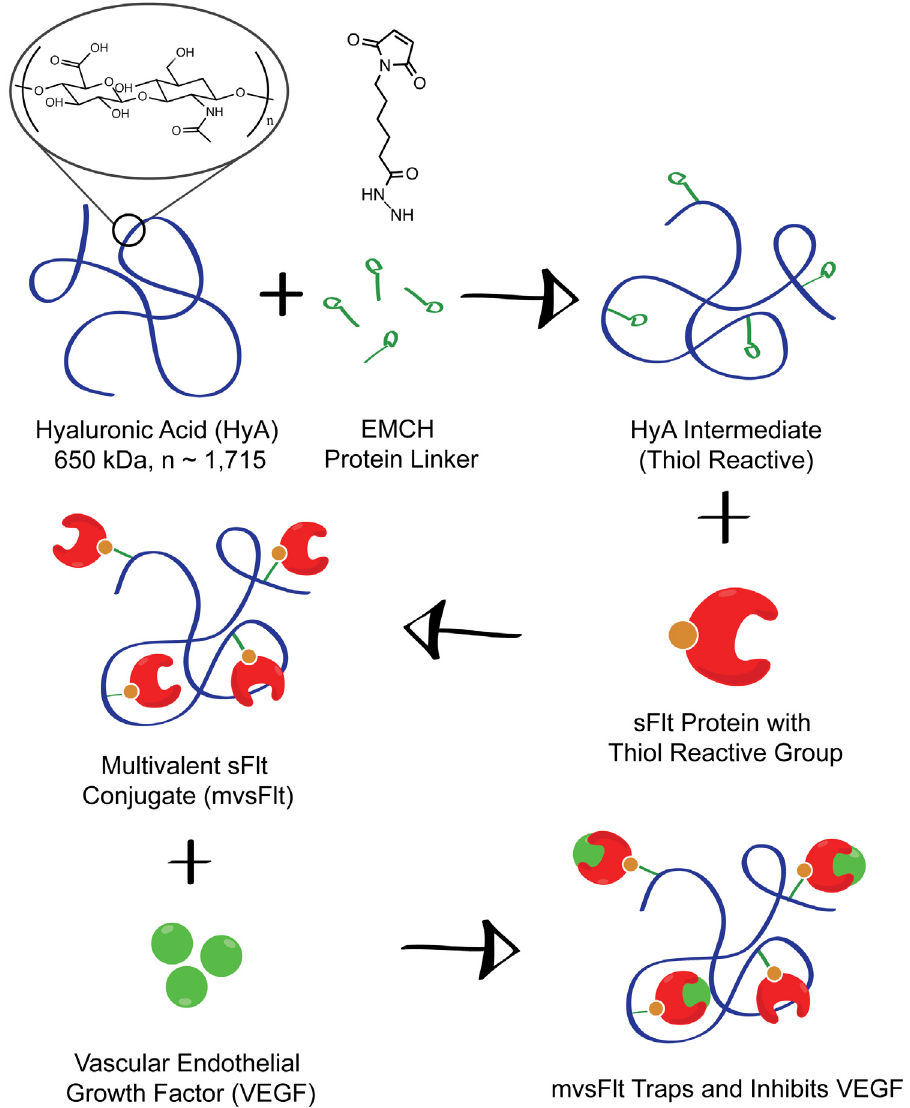
Fig 1. Synthesis of mvsFlt schematic. mvsFlt bioconjugates were synthesized using a 3-step reaction in which HyA was reacted with EDC and EMCH to create a thiol reactive HyA-EMCH intermediate. sFlt was then treated with 2-iminothiolane and reacted with the HyA-EMCH intermediate for the synthesis of the final mvsFlt